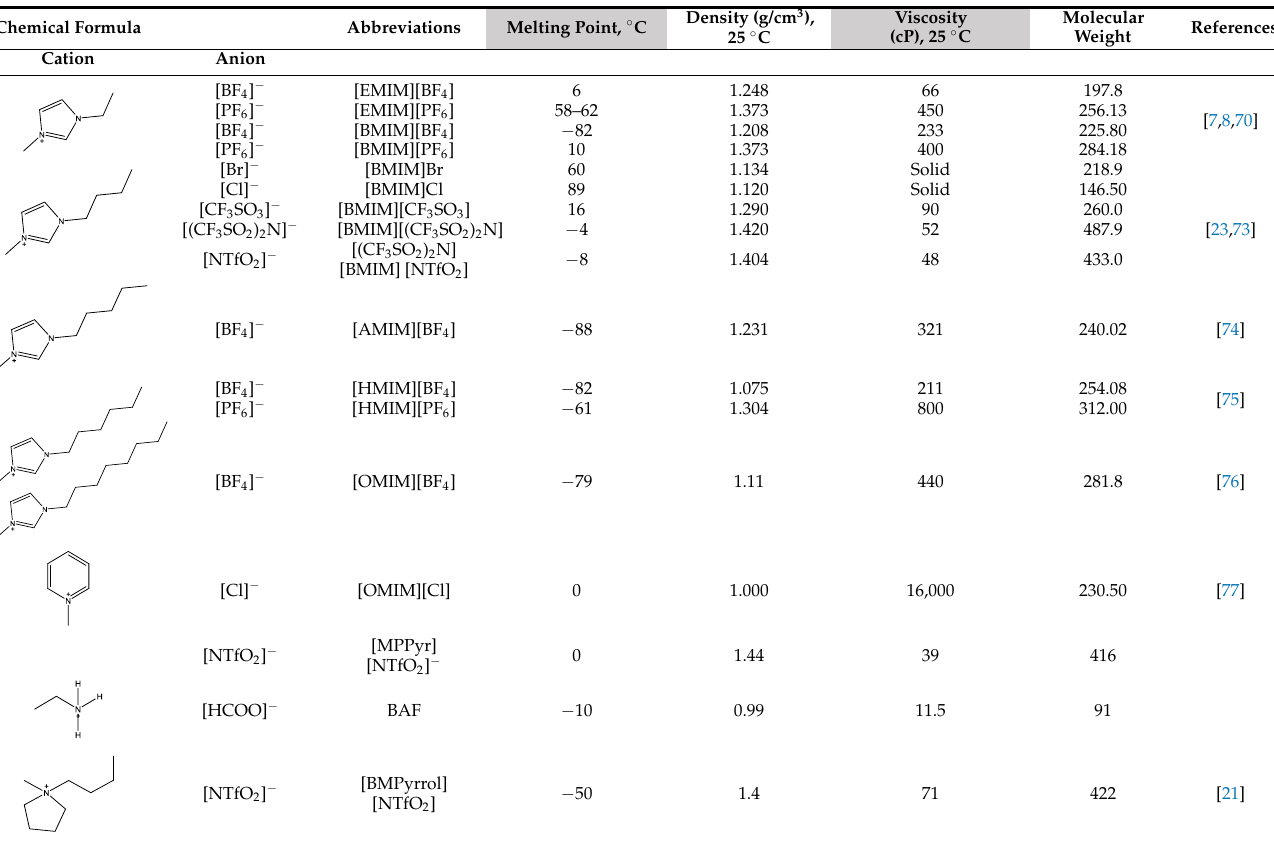
Table 2. Physical properties of ILs used in separation technology.